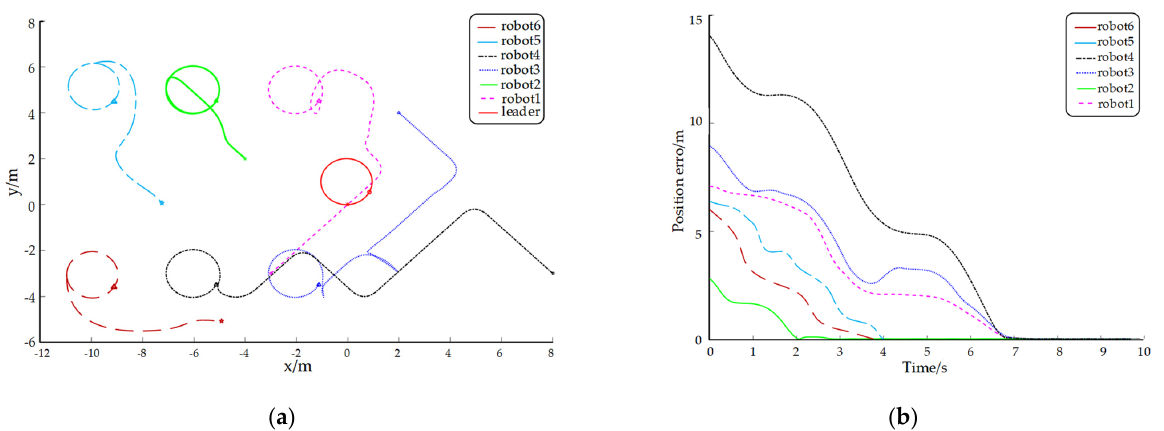
Figure 11. ( a ) Trajectories of multi-robot on the plane without grouping strategy; ( b ) Formation position error of each following robot.